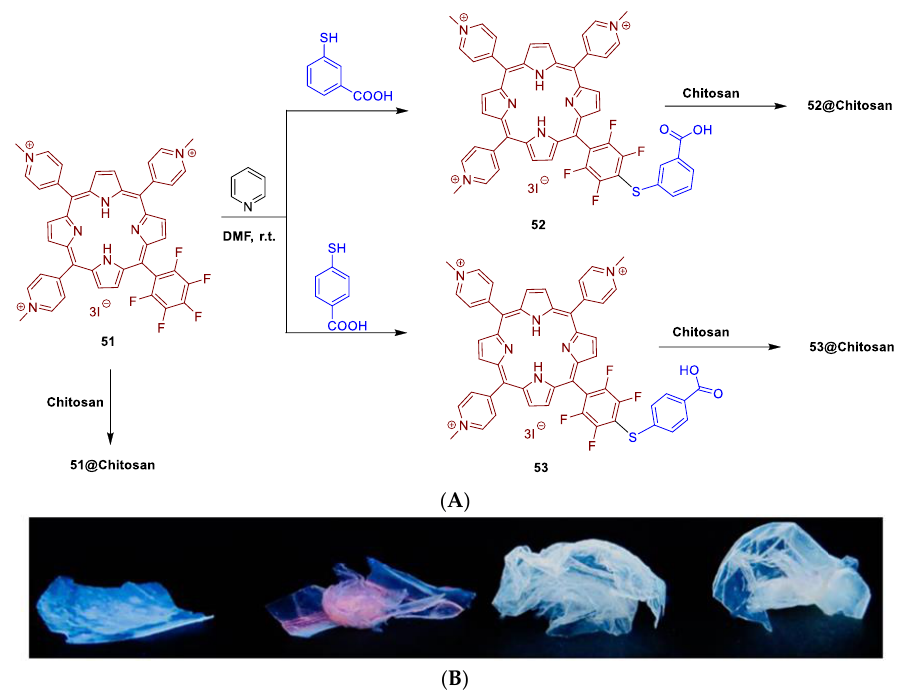
Figure 35. ( A ) Synthesis of porphyrinic derivatives 51, 52, 53 and their immobilization on chitosan giving 51@chitosan , 52@chitosan and 53@chitosan . ( B ) From left to right: Images of chitosan